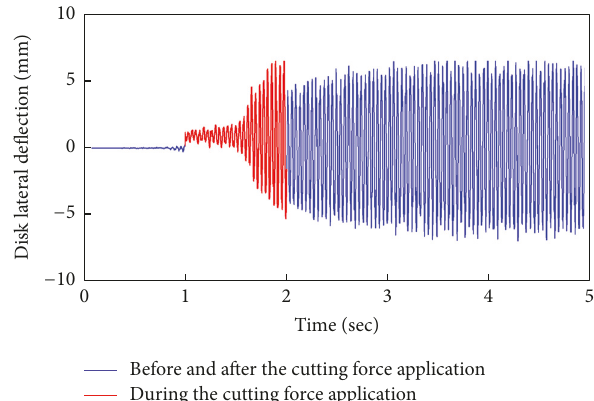
Figure 17: FEM results, disk lateral deflection at position of outer radius, angle 90 ∘ , subjected to cutting forces, at rotation speed 2800